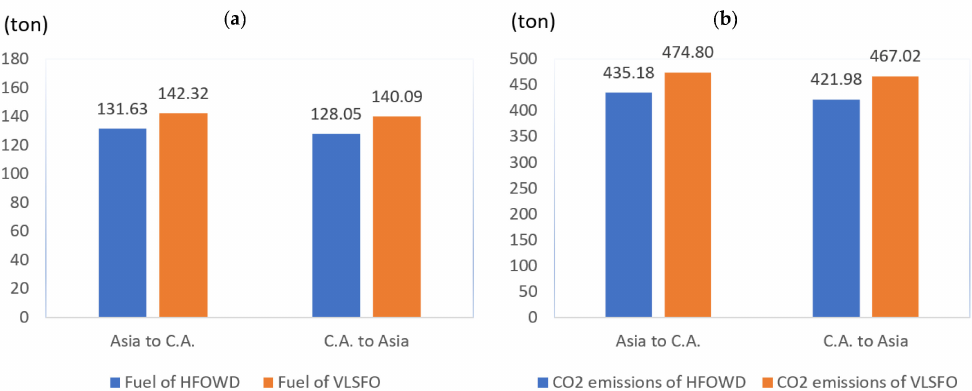
Figure 2. Compare the HFOWD (in blue) and VLSFO (in orange) from Asia to C.A, back and forth: ( a ) fuel consumption of the VLSFO is significantly higher than the HFOWD; ( b ) CO 2 emissions of the VLSFO are significantly higher than the